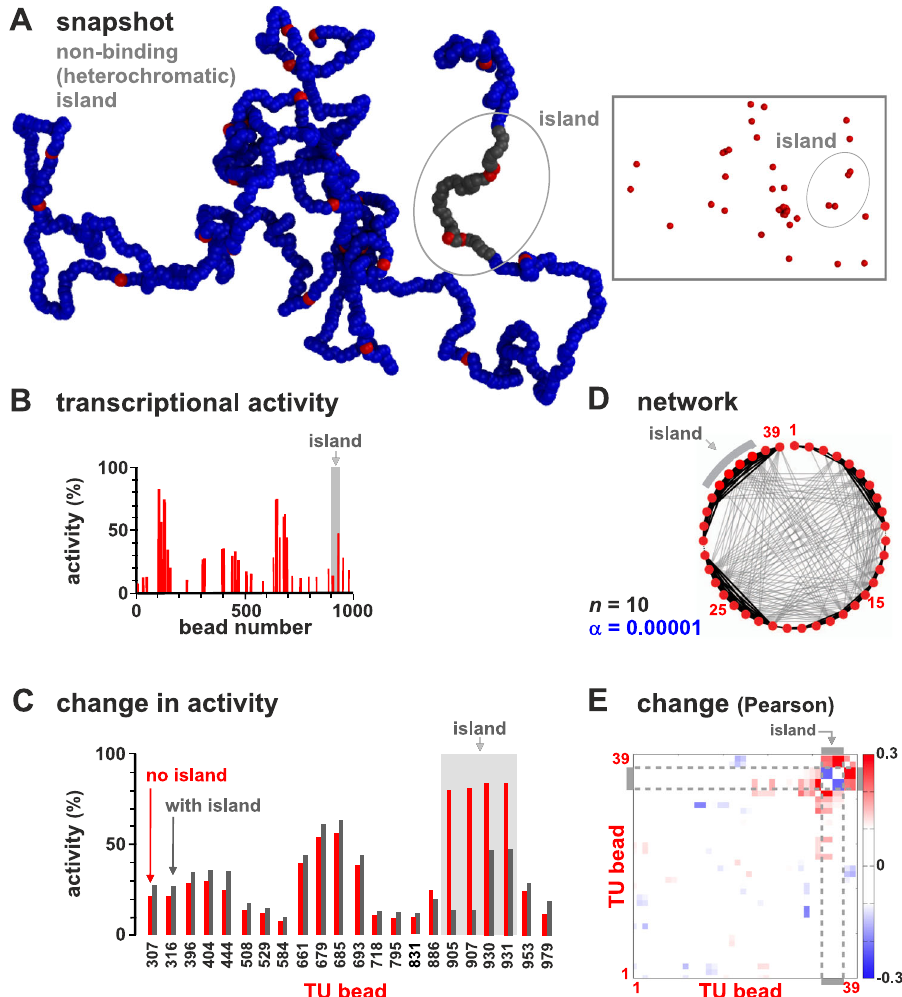
Fig. 6 Neighboring heterochromatin affects transcriptional activity. Results from two sets of simulations (at least 800 runs for each condition) are compared; one set as Fig. 1, in the other beads around TU beads 905, 907, 930, and 931 (from bead 901 to 940) are non-binding (to represent embedding the TU beads in heterochromatin). A Snapshot with heterochromatic beads shown in gray (TFs not shown; inset — the same structure with only TUs). B Average transcriptional activity for each TU. C Comparison of average transcriptional activity with respect to wild type for the 22 TUs with signi fi cantly different values in the two sets ( p ≃ 0.003; two-sided Student ’ s t -test). D Regulatory network inferred from the matrix of Pearson correlations between activities of TUs (as Fig. 3A). E Change in Pearson correlation between TUs due to